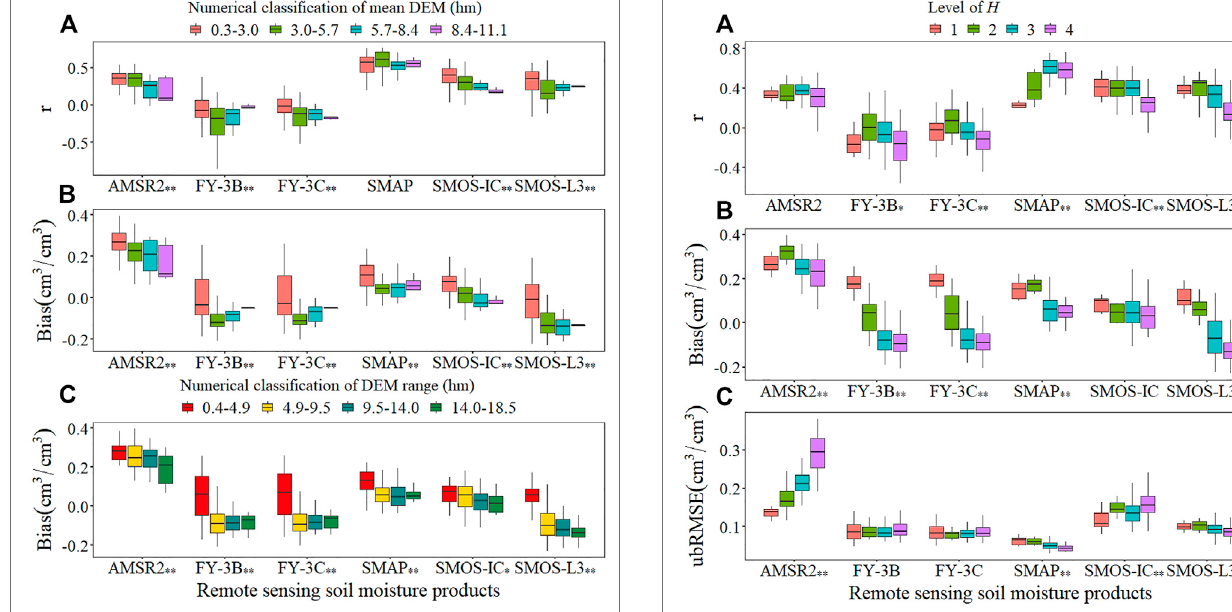
FIGURE 6 | Box diagram of land cover information entropy and error coef fi cient of each product. H denotes the information entropy, * indicates